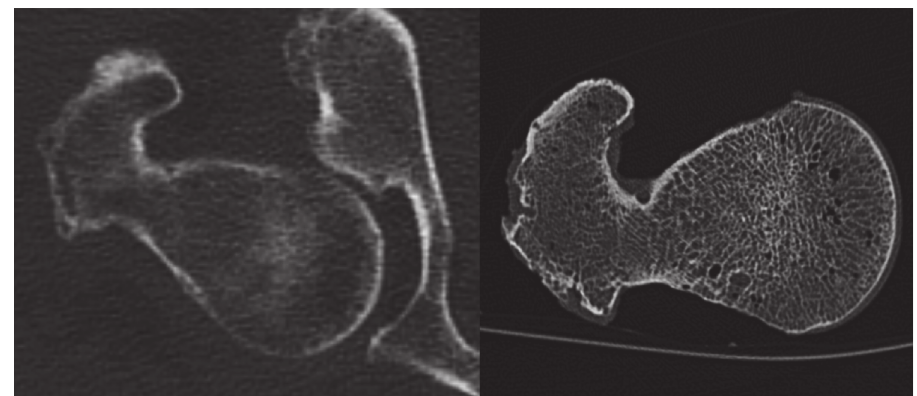
Fig 1. In vivo CT Image of a proximal femur with image noise and artifacts caused by surrounding soft tissue compared to an in vitro CT Image with better depiction of the trabecular and cortical structures. The spatial resolution, determined at ρ 50 of the modulation-transfer-function, is 230 μ mx230 μ m in vitro and 250 μ mx250 μ m in vivo